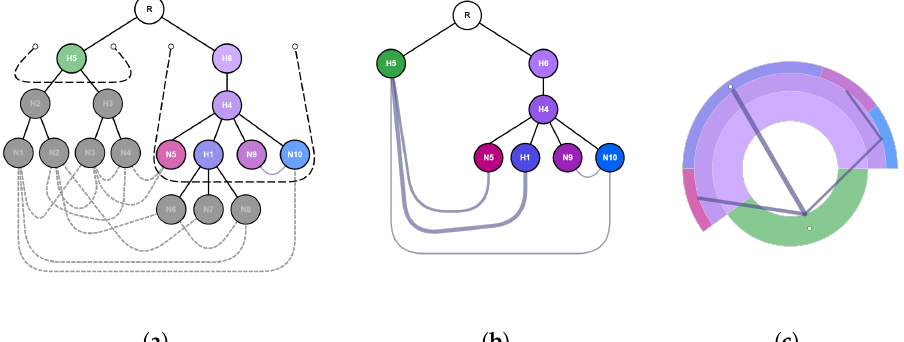
Figure 6. Collapse operations are applied to the meta-nodes H1 and H5. ( a ) Shows a node-link repre- sentation of the original graph and how the collapsing operations would be applied. ( b ) Illustrates using a node-link representation of the status after the collapsing operations, i.e., how H1 and H5 descendant nodes are removed and their connections are aggregated in the meta-edges incident on H1 and H5. ( c ) Shows how Carbonic would represent the same graph after the collapsing operations. The fact that a meta-node is collapsed is visually represented by a circle inside the sector, which also serves as a handler for interactively applying the reverse uncollapse